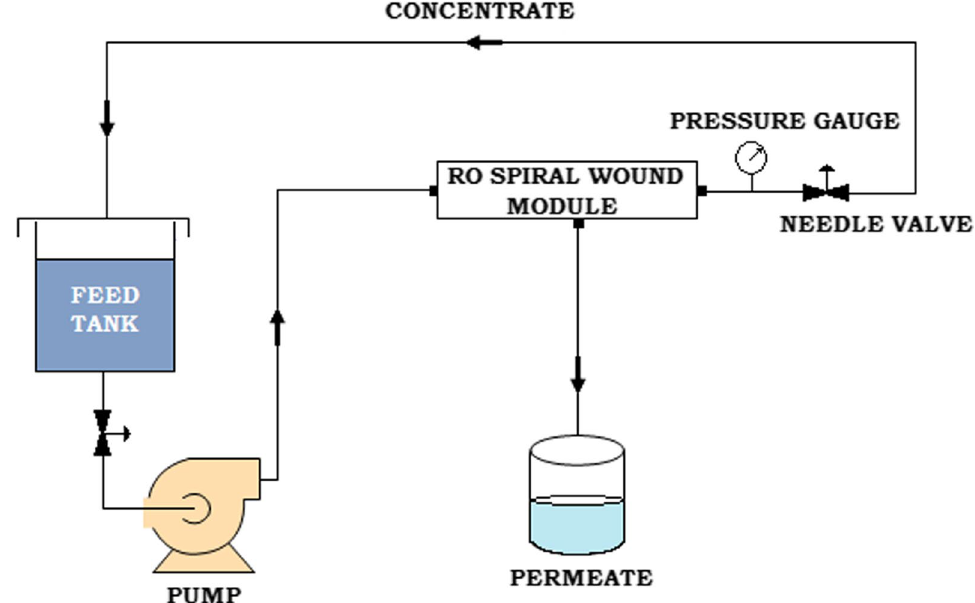
Fig. 3 Schematic of laboratory reverse osmosis